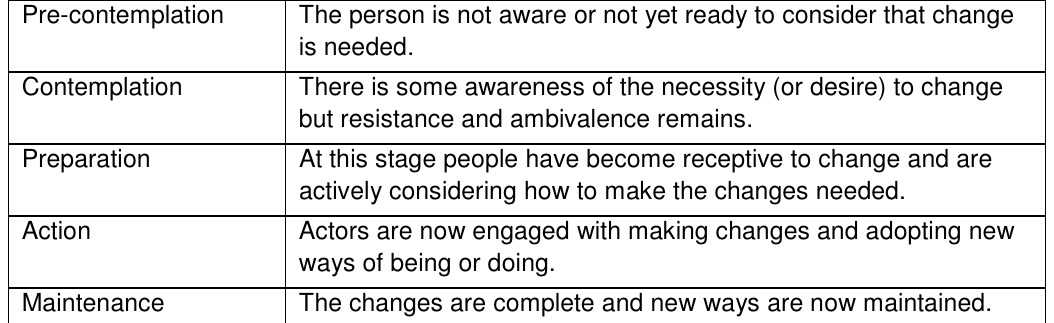
TABLE 1: STAGES OF CHANGE